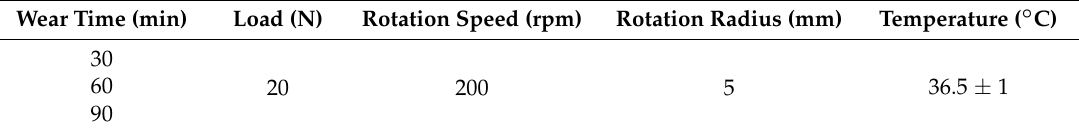
Table 4. The experimental parameters of the wear tests.